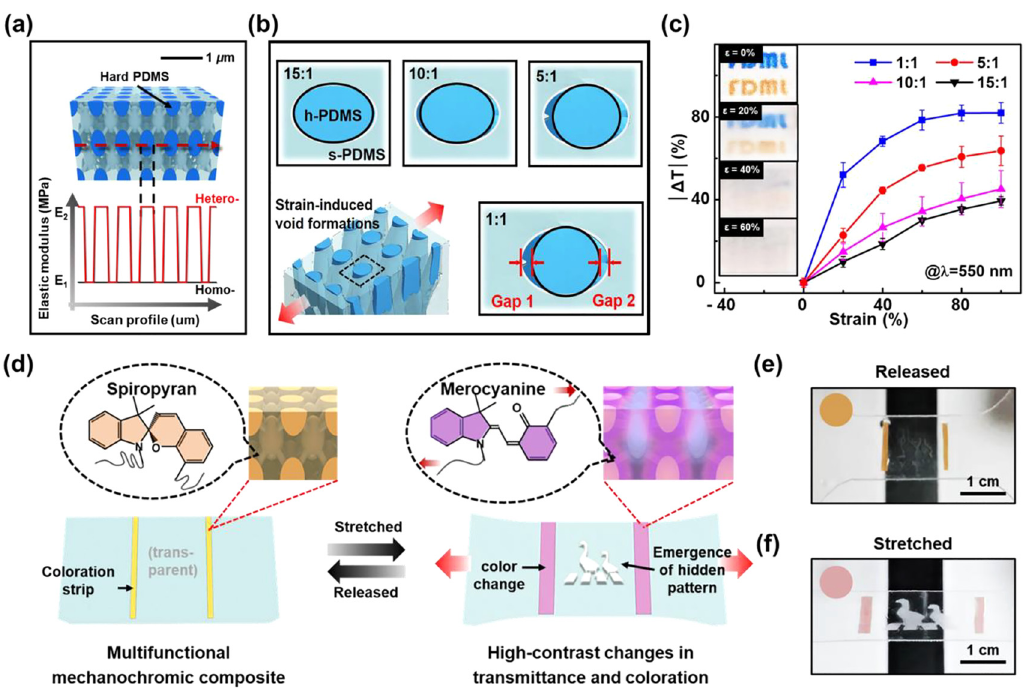
Figure 10: Mechanical modification of 3D scatterer to improve optical modulation performances. (a) Modulusmismatch inthe interdigitated3D network. (b) Nanogap formation at 30%strain in3D modelswith different heterogeneity values in FEA simulation. (c) Transmittance modulating performance of 3D heterogeneous scatterers as a function of modulus mismatch and applied strain. (d) Schematic illustrations showing the simultaneous modulation of transmittance and color by preparing multifunctional mechanochromic composites and the resulting images under (e) released and (f) stretched states. Reprinted with permission from Ref.